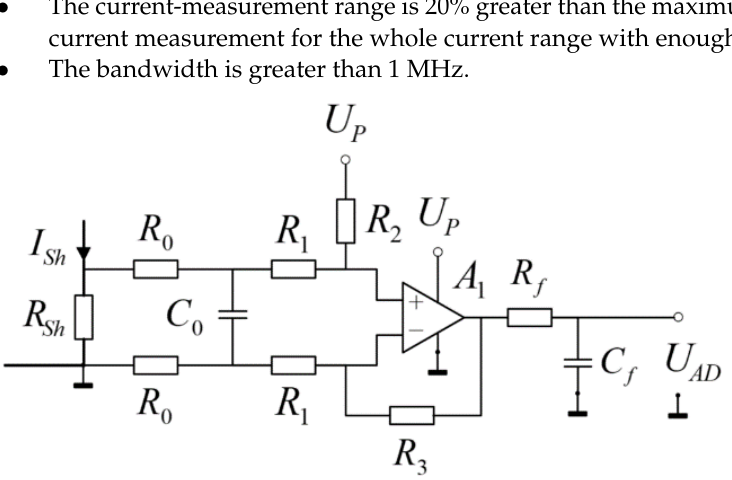
Figure 14. Current-measurement circuit.